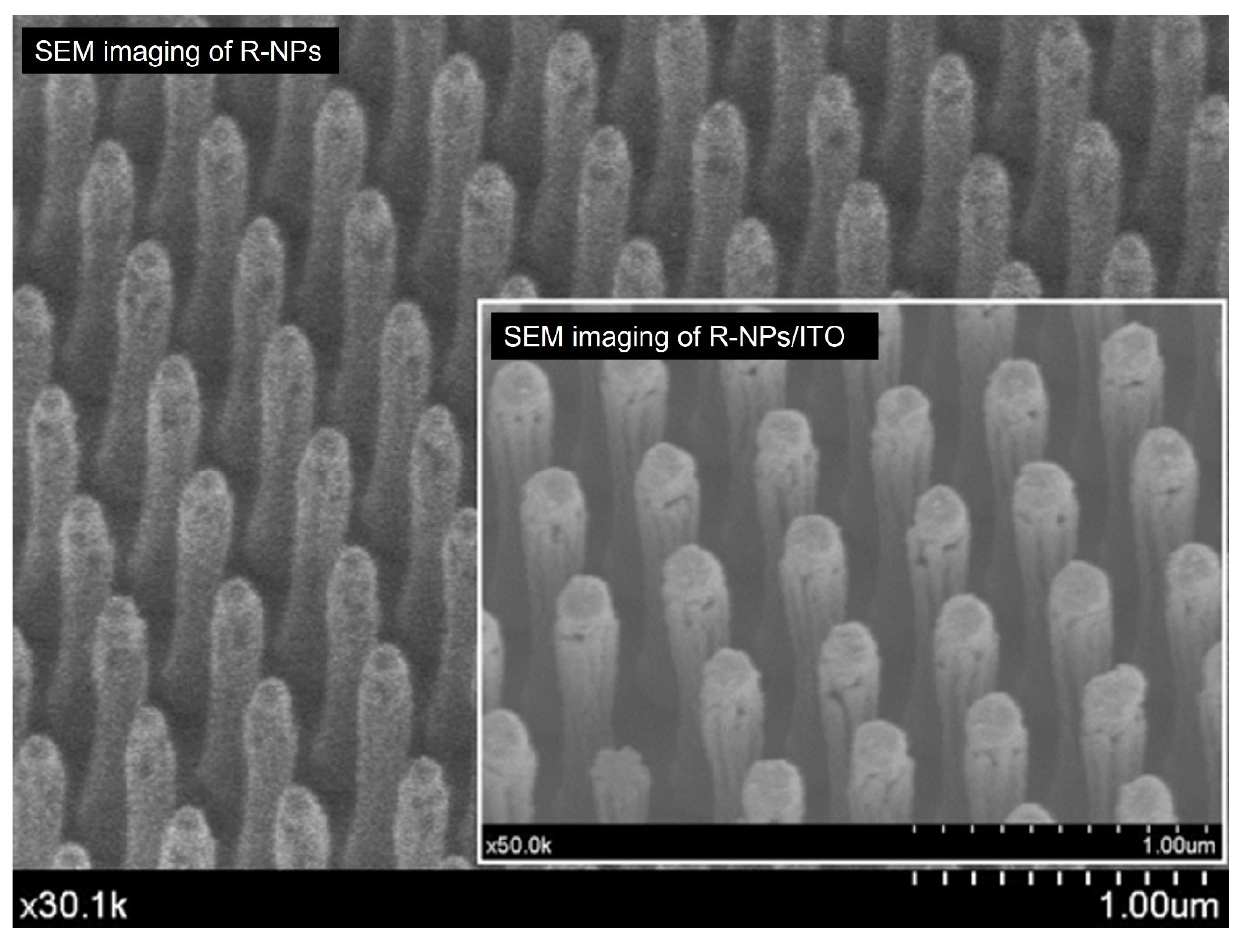
Figure 1. Reflectivity spectra comparison of ( a ) R-NPs and ( b ) R-NPs/ITO in deionized water (H 2 O) and cyclohexane.